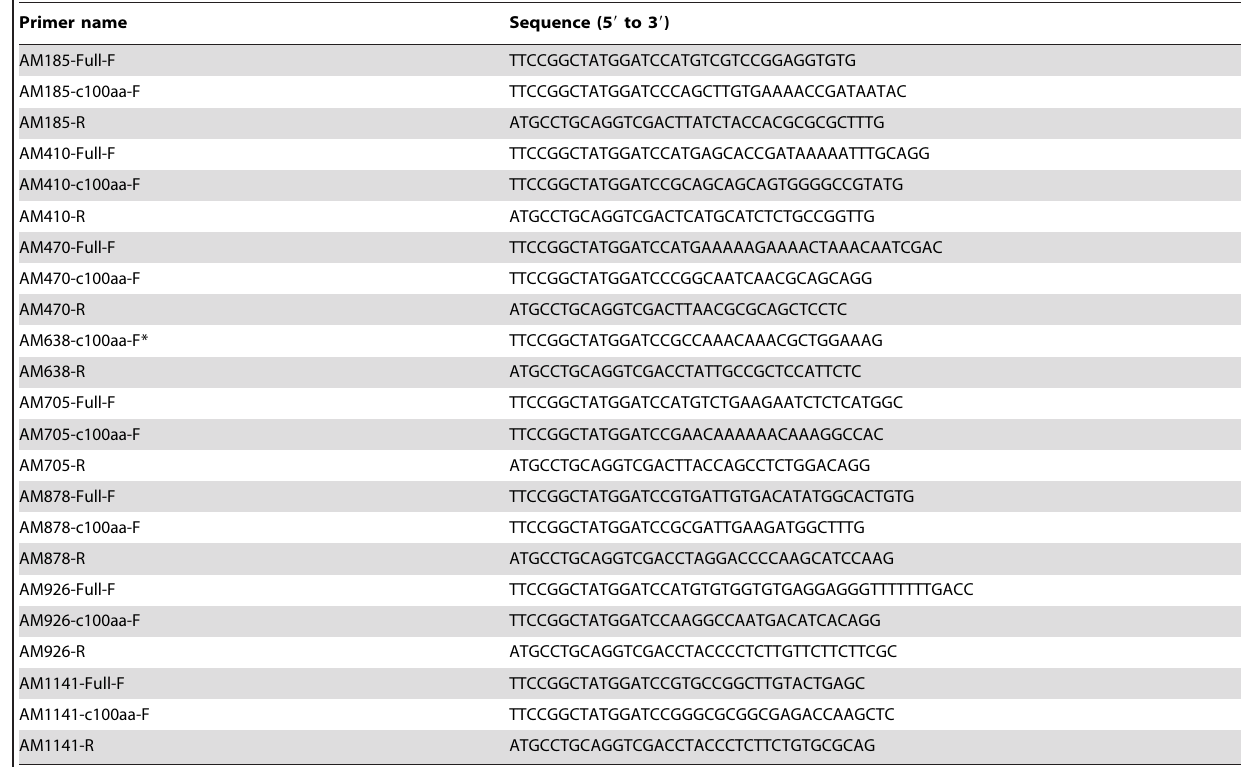
Table 2. Primer sequences used in this